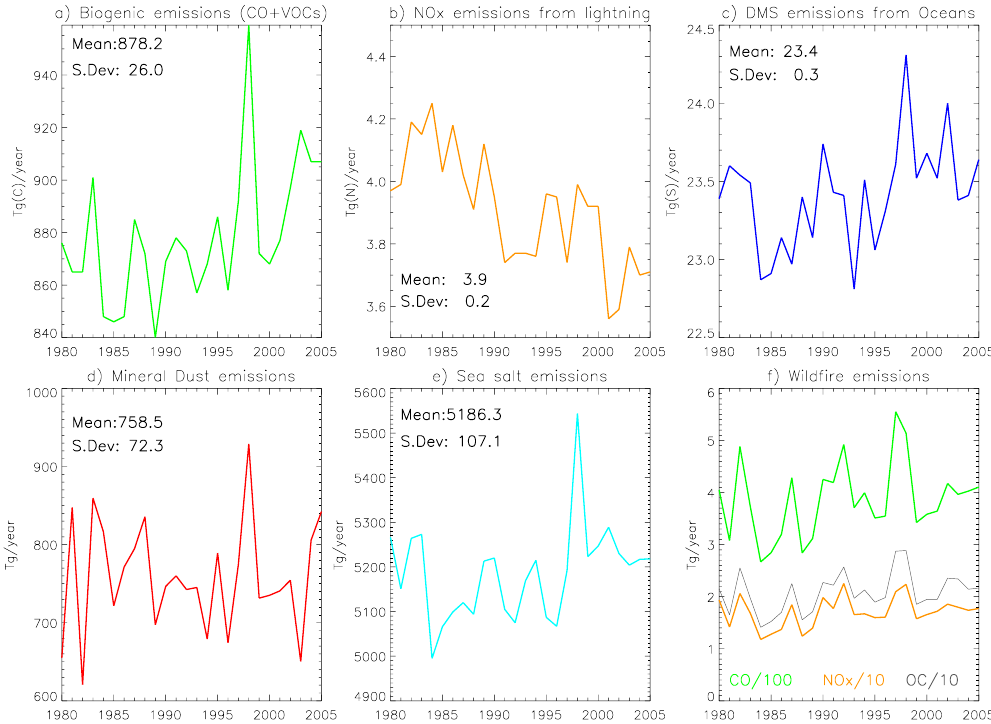
Fig. 3. Total annual natural and biomass burning emissions for the period 1980–2005: (a) biogenic CO and VOCs emissions from vegetation; (b) NO x emissions from lightning; (c) DMS emissions from oceans; (d) mineral dust aerosol emissions; (e) marine sea salt aerosol emissions; (f) CO, NO x , and OC aerosol biomass burning